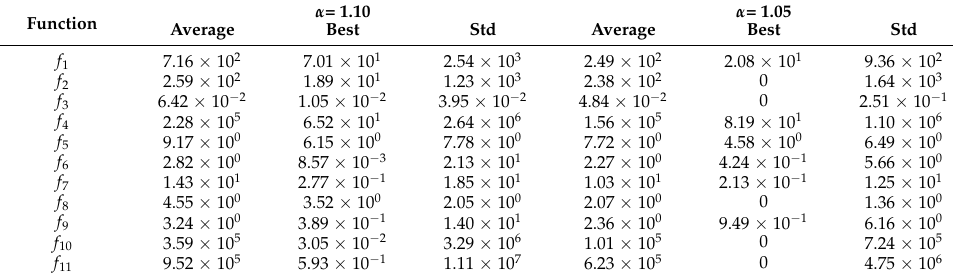
Table 4. Results of HDBBO with different values of α .